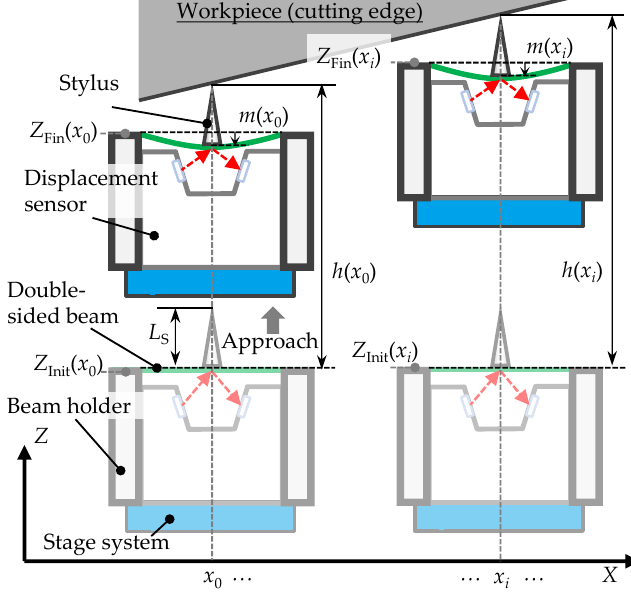
Figure 2. The measurement principle of the tool edge profiler.